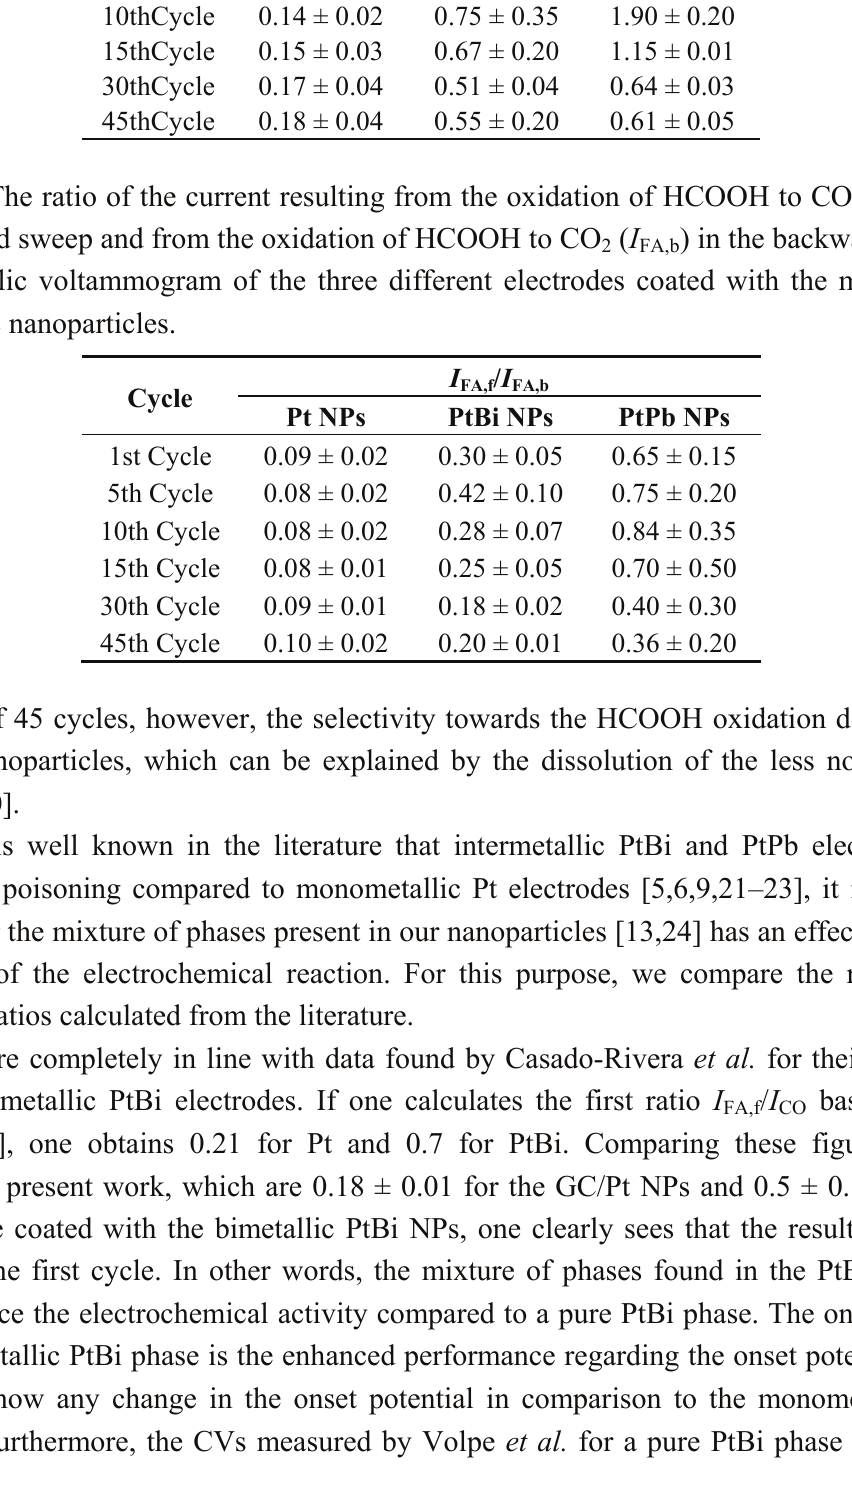
( I ) in the forward scan of the cyclic voltammogram of 2 CO